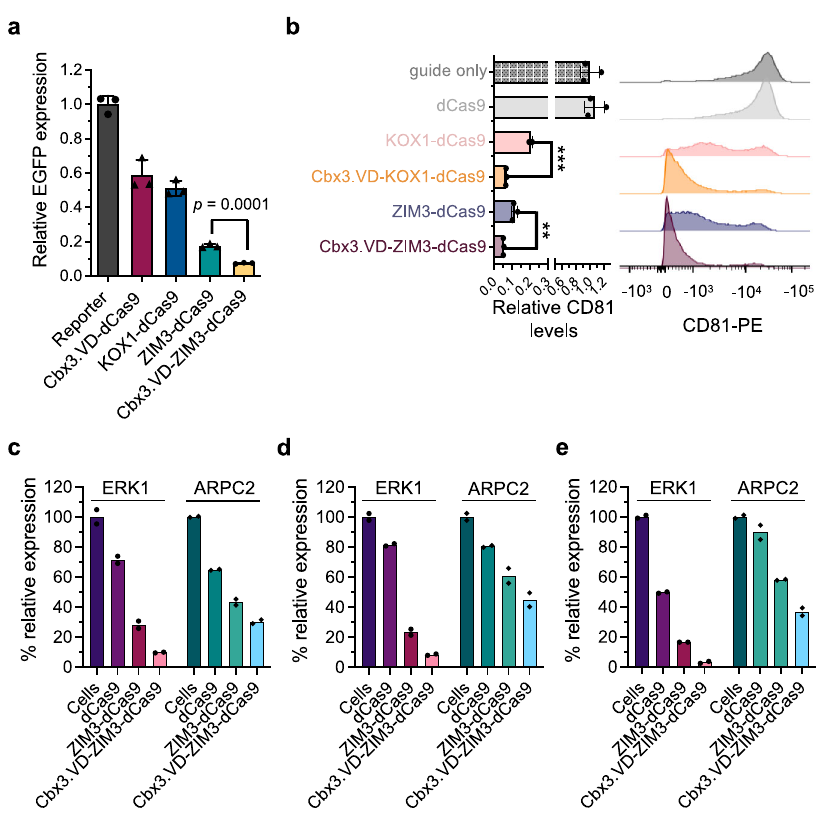
Fig. 5 | Cbx3.VD enables modular and potent gene repression. a Relative EGFP levelsof HEK293T-SV40EGFPreportercellsstably transduced with different KRAB domain-containing repressors (KOX1-dCas9, ZIM3-dCas9, and Cbx3.VD-ZIM3- dCas9)andarepressorlackingKRABdomains,obtainedbydirectlyfusingCbx3.VD to dCas9 (Cbx3.VD-dCas9). Histograms show the mean from three independent experiments ±1SD of EGFP levels relative to untransduced reporter cells. b Repression of endogenous CD81 . CRISPRi repressorswere recruited to CD81 TSS and CD81 surface expression levels were measured by fl ow cytometry 4 days after antibiotic selection of repressor-transduced cells. Left panel shows CD81 surface levels relative to HEK293T cells transduced only with gRNA targeting CD81 pro- moter (guide only). Data are mean from three independent measurements ± 1SD,